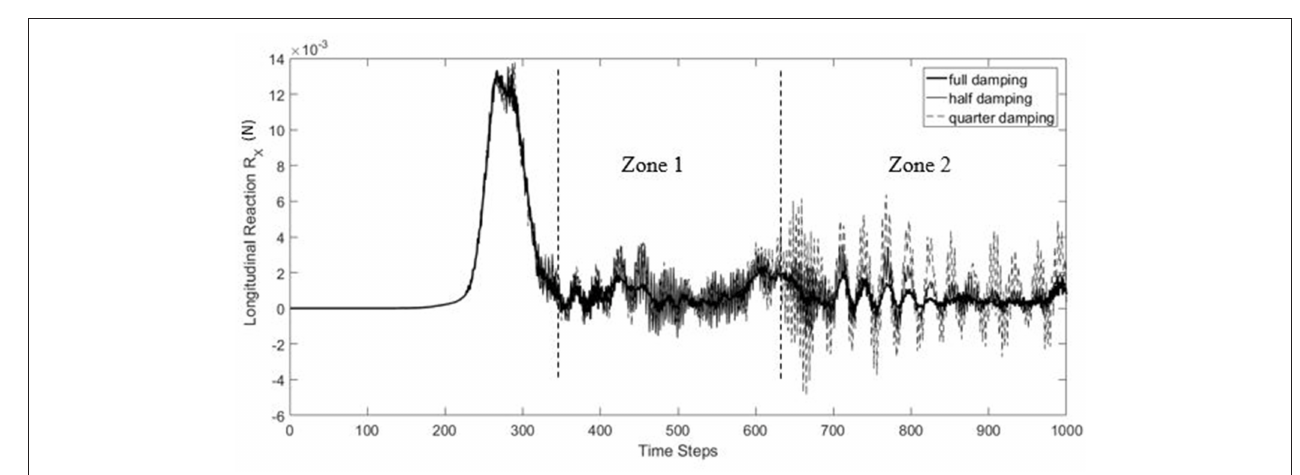
FIGURE 4 | Comparison between time histories of longitudinal reaction R X corresponding to different